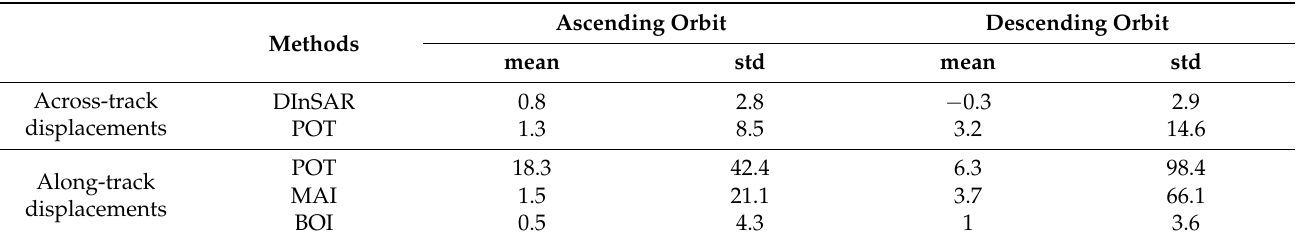
Table 2. The accuracies of the across- and along-track displacements derived from DInSAR, POT, MAI and BOI approaches (unit: